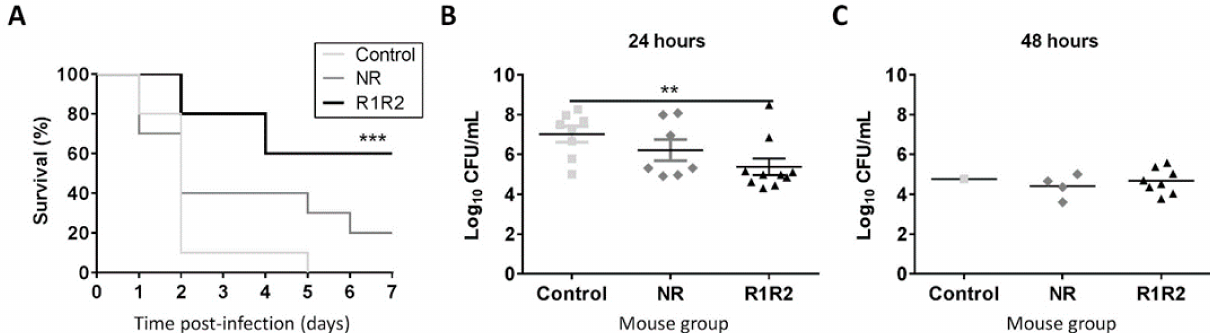
Figure 3. Protection against pneumococcal sepsis. ( A ) Time-course survival rates for sepsis in immunized mice after bacterial inoculation. CFU/mL counts in blood at 24h ( B ) and 48h ( C ) post-infection via intraperitoneal are shown. Statistical significance of survival was analyzed by the log rank (Mantel-Cox) test whereas CFU/mL was analyzed by Student’s t-test. ** p < 0.01; *** p < 0.001.